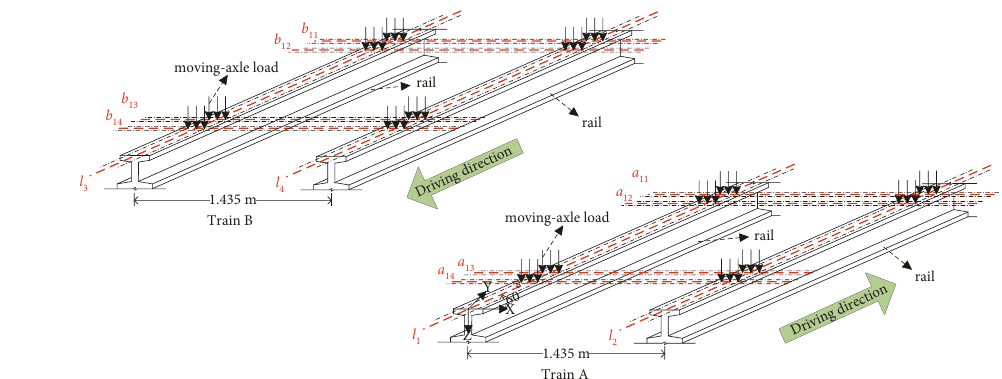
Figure 7: Schematic diagram of the constrained area of the first carriage with moving-axle loads on rails. observation points along the left and right bottom floors of shield machine successively arrived at the 38 th , 52 th , and 67 th the existing tunnel also increases. When the left-line shield rings. It is seen that when the speed of train increases from machine advances to the 15 th ring, which is about to enter 50 km/h to 125 km/h, the peak acceleration of the